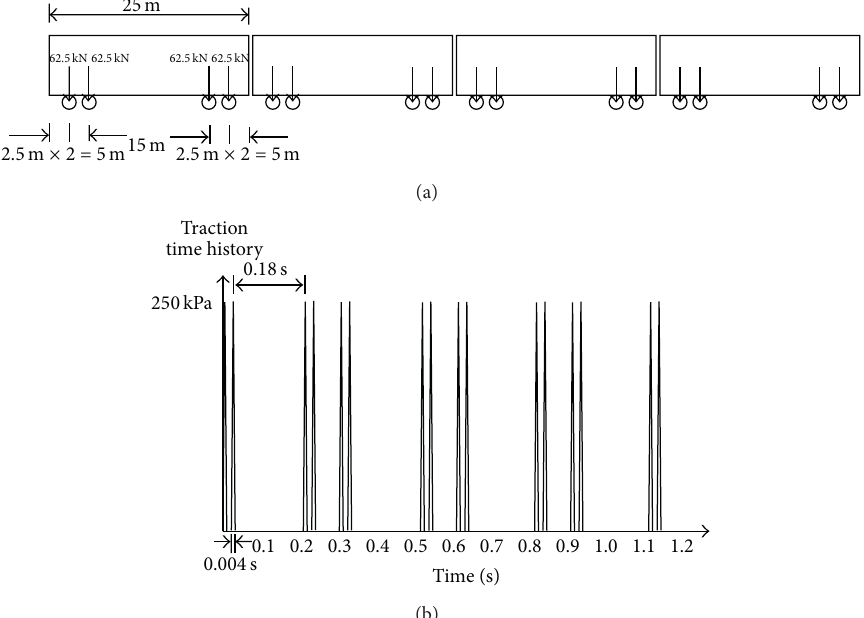
Figure 3: (a) The dimension of a high speed train (4 carriages) and (b) traction time history of wheel loading.